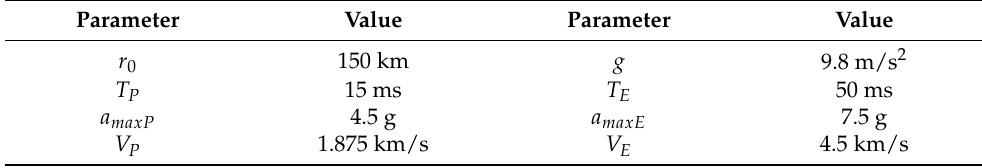
Table 4. Parameters of the simulation scenario.